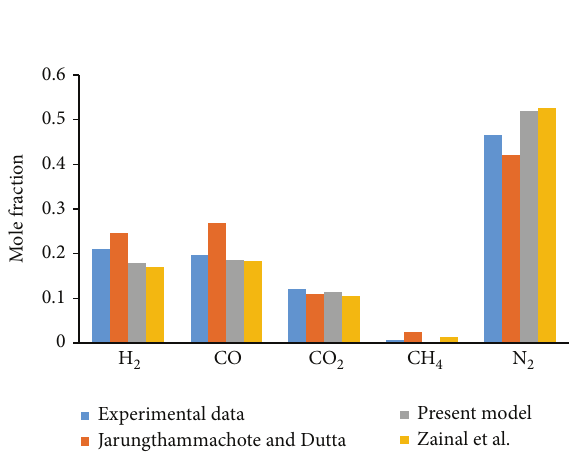
Figure 2: Mole fraction of syngas for present and other experimen- tal and numerical